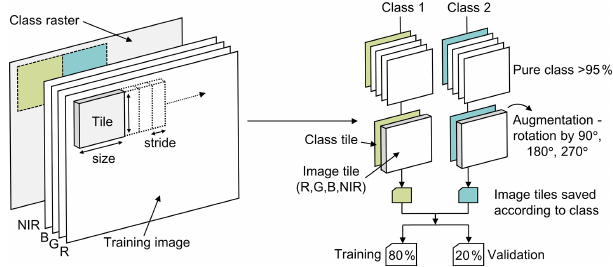
Figure 5. Conceptual diagram of the tiling process used to create training and validation data. A specified tile size and stride were used to extract tiles from the class raster and training image. Image tiles were filtered, augmented, and saved to individual class folders using an 80% / 20% split for training and validation